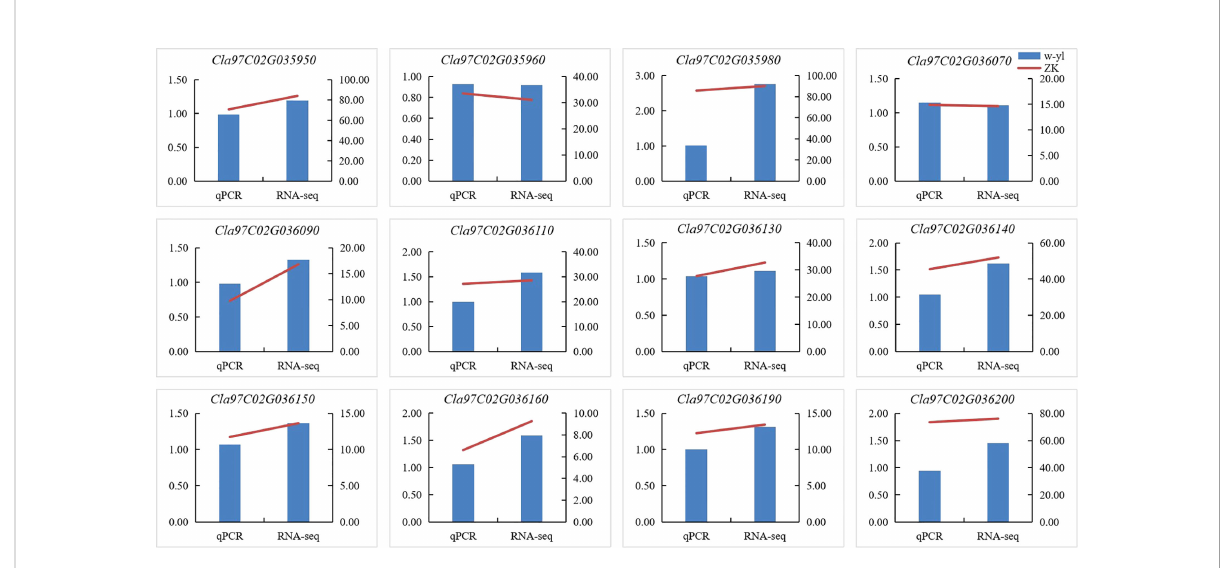
FIGURE 5 Veri fi cation of DEGs by